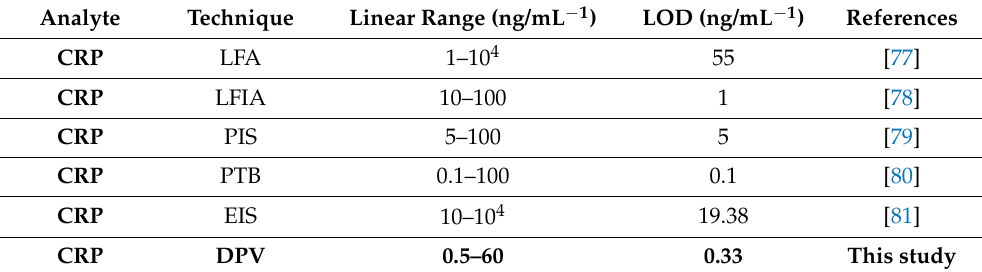
Table 2. Some biosensor studies developed for CRP detection.